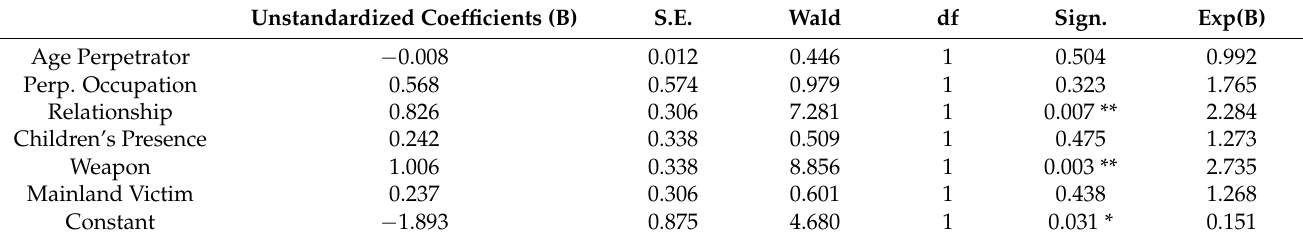
Table 6. Logistic regression model predicting the violence maltreatment during the COVID-19 lockdown. Unstandardized Coefficients